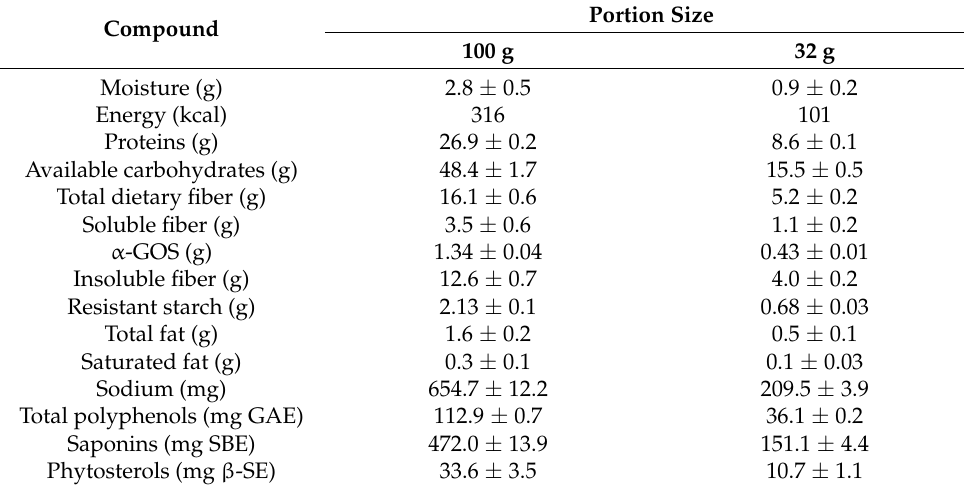
Table 1. Chemical composition of the common bean baked snack 1